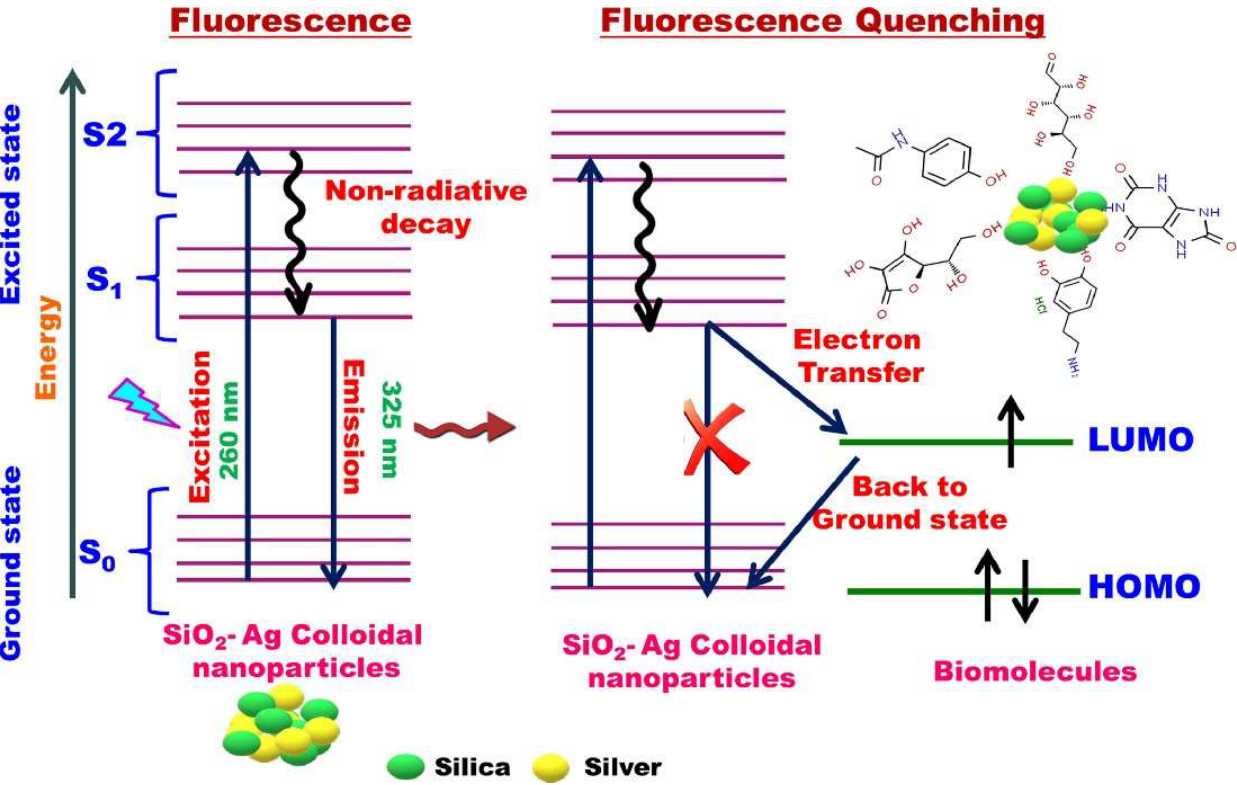
Figure 3. Schematic diagram for fluorescence quenching in SiO 2 -Ag colloidal nanoparticles with the addition of biomolecules (Reprinted with permission from Ref. [45]. Copyright 2021, Elsevier).